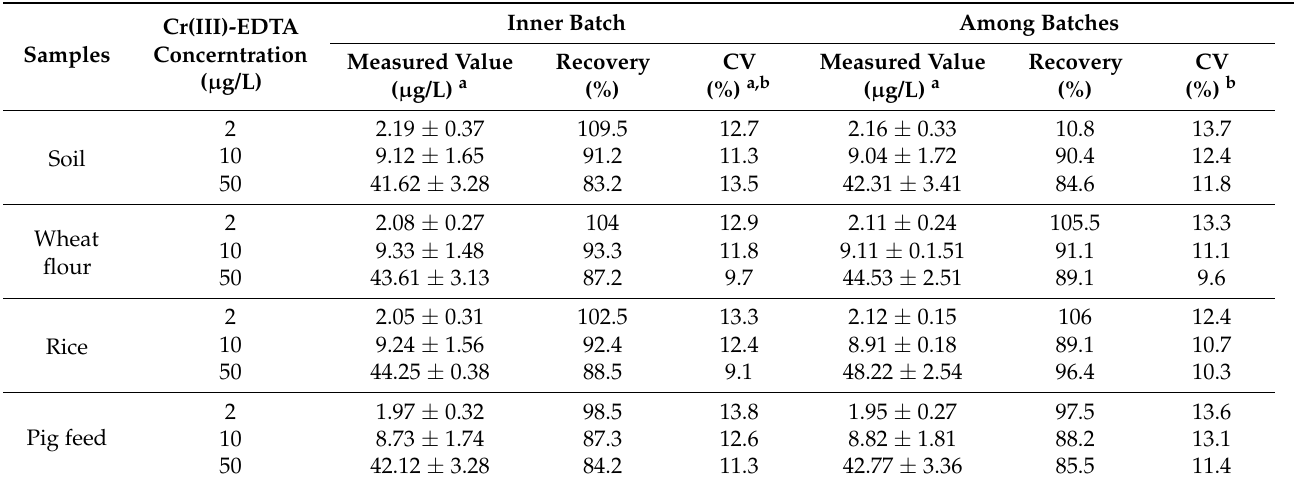
Table 4. Accuracy and precision measurements of the icELISA for Cr(III)-EDTA.